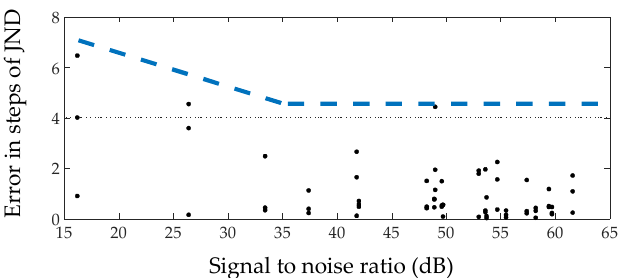
Figure 15. C 80 parameter value errors measured with a handclap (compared to measurements with a dodecahedron) in steps of JND as a function of the signal-to-noise ratio for different octave bands. The dashed line represents a threshold below which all JND values were measured.